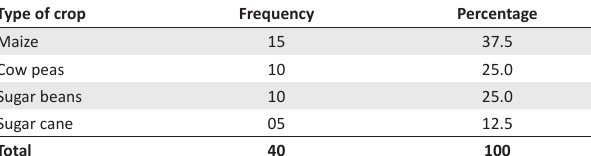
TABLE 2: Types of crops grown by small-scale farmers in Shurugwi district ( N = 32). Type of